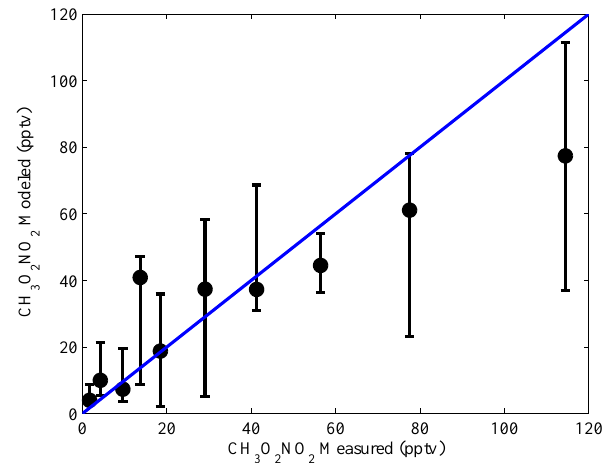
Figure 11. Binned modeled vs. measured CH 3 O 2 NO 2 . The bars identify the interquartile of the modeled CH 3 O 2 NO 2 . The blue line has a slope of 1 for